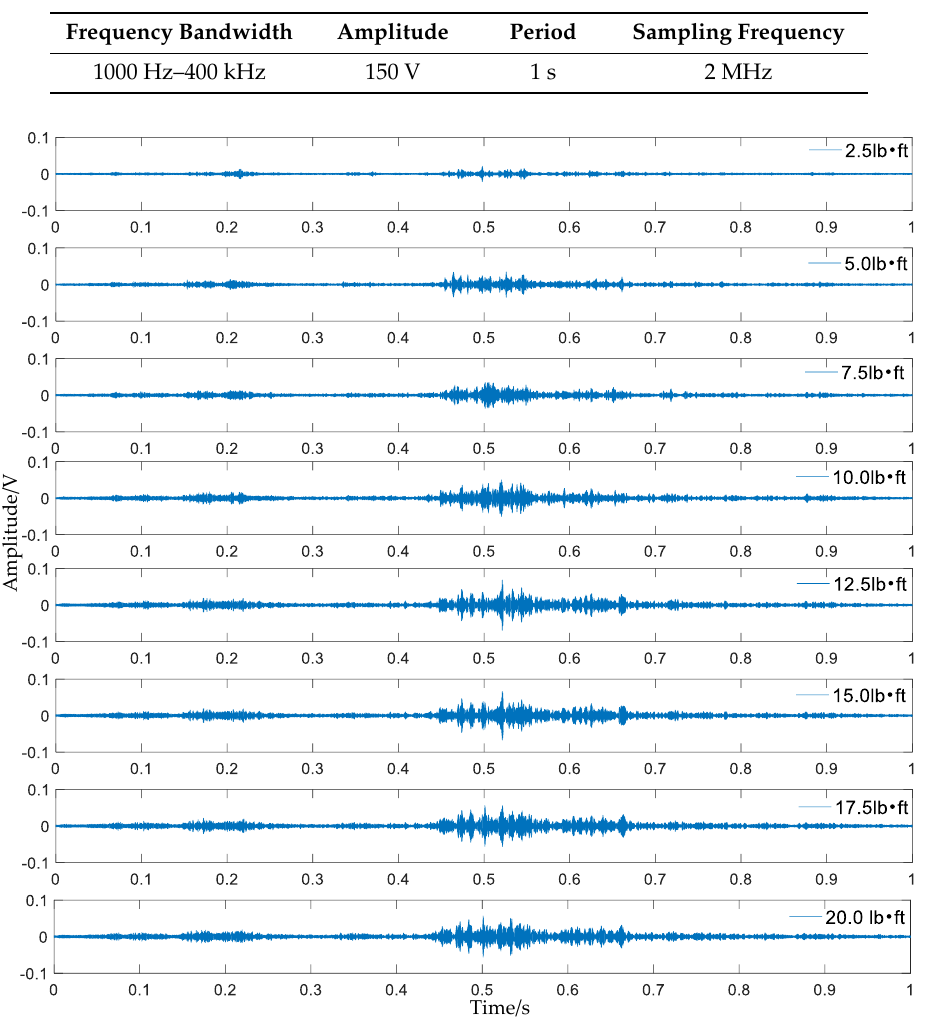
Figure 8. Received signals under eight different torque levels of bar 5.